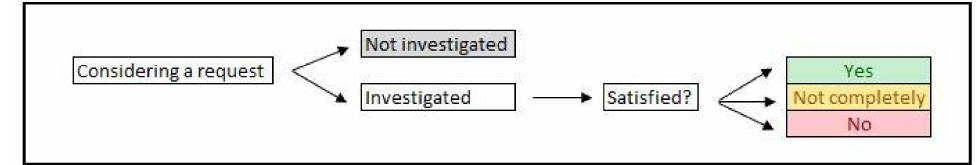
Figure 2. Logical path for Requests